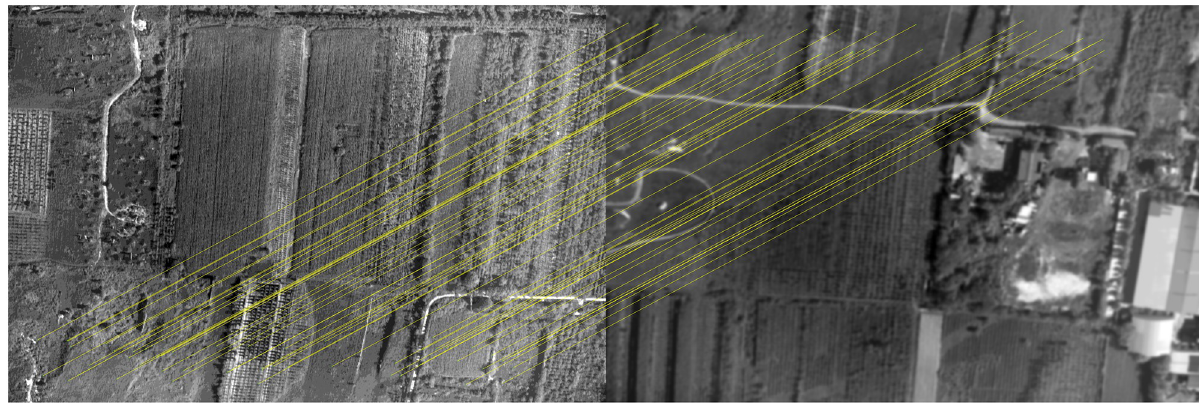
Fig 19. Matching results of aerial images with different sharpness by algorithm in this paper.